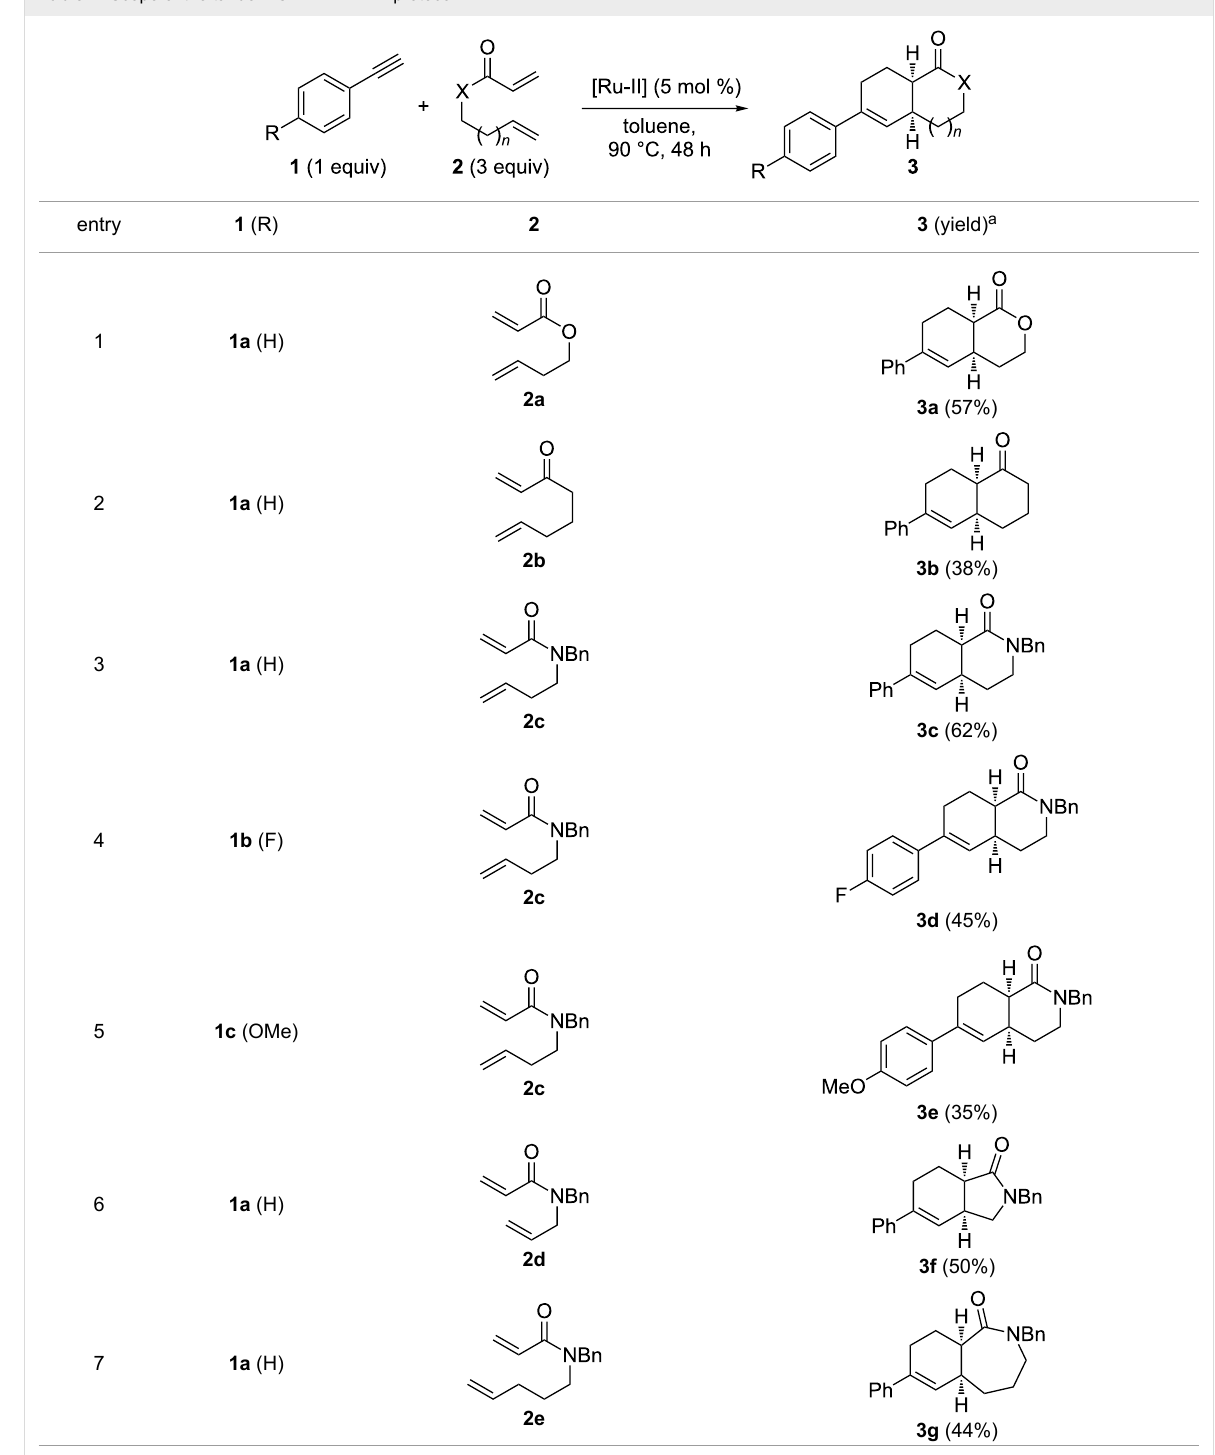
Table 2: Scope of the tandem CEYM-IMDAR